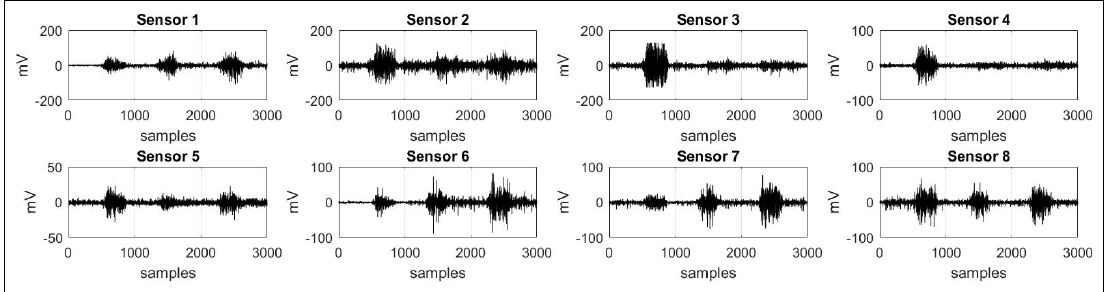
Figure 2. Raw time domain surface electromyogram (sEMG)